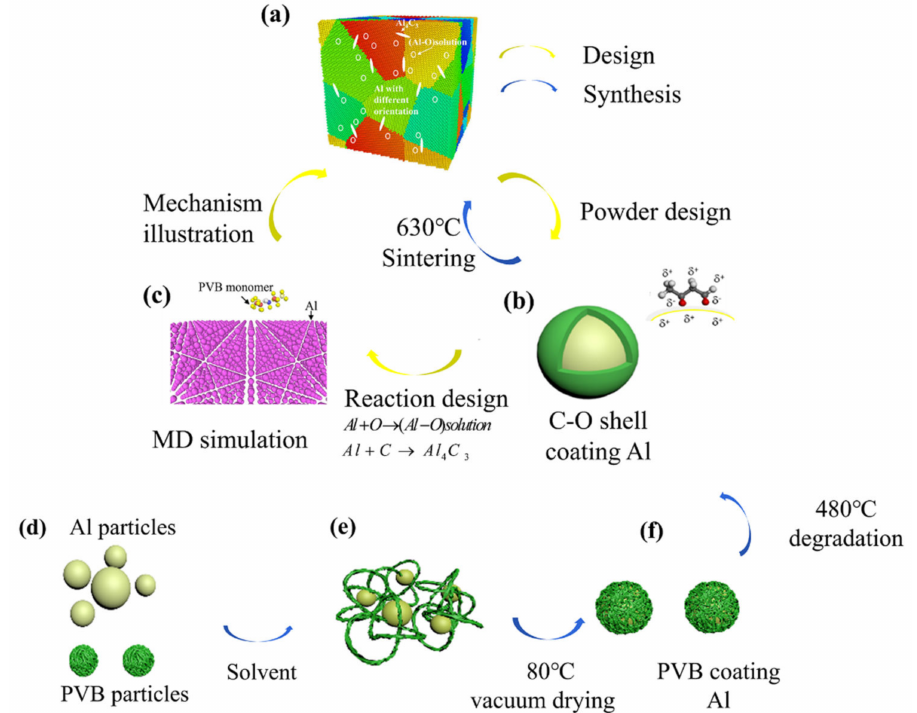
Figure 1. Schematic of the structural design and powder preparation flow chart: ( a ) designed structure of the C-O / Al composite, ( b ) designed powder structure, ( c ) molecular simulation of the reaction design, ( d ), ( e ), and ( f ) schematic diagram of the powder